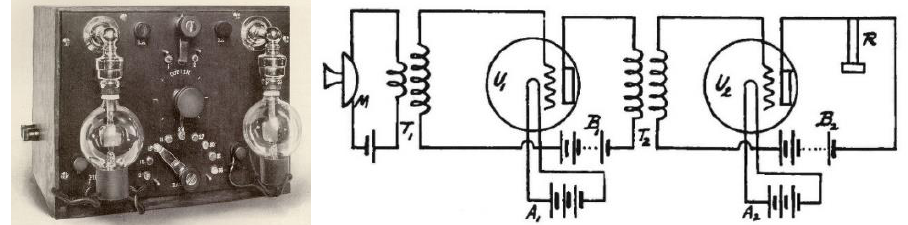
Fig. 8. Schematic diagram of a two-stage audion frequency amplifier at de Forest’s audions and its general appearance in the form of a finished design.